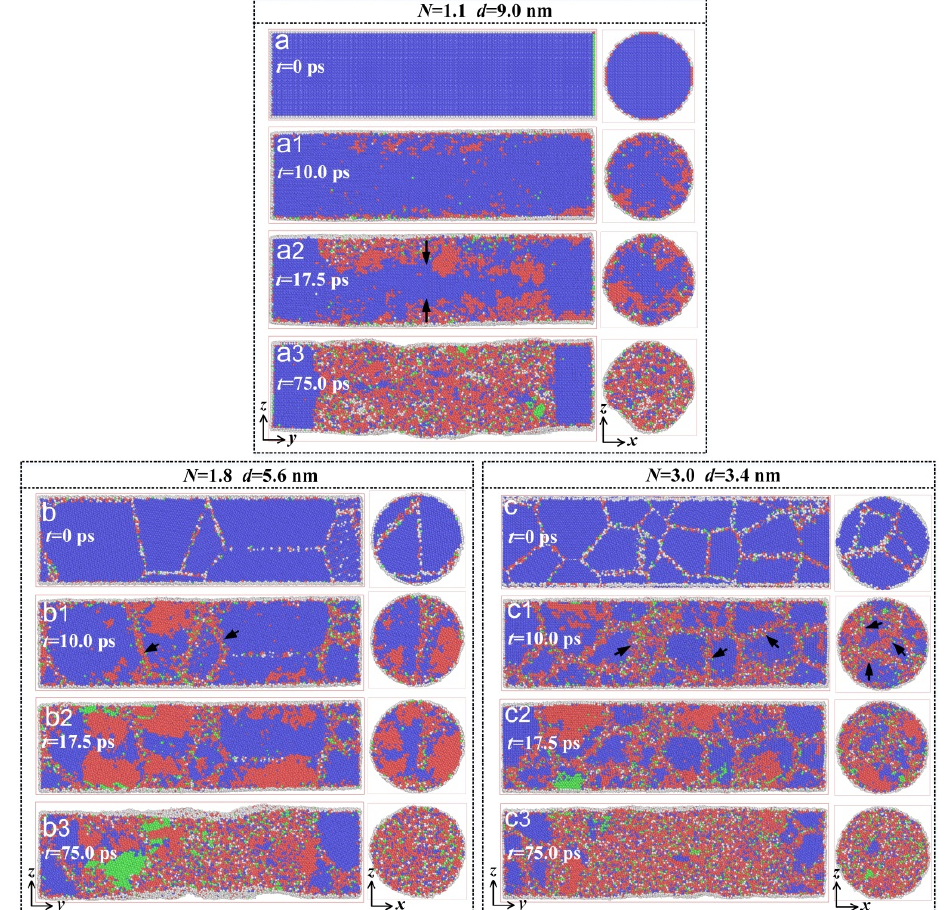
Figure 5. The microstructural evolution of different models at various times during the torsion sim- ulation. (a) Single crystal model with an average grain size of 9.0 nm, t = 0 ps; ( a1 ) t = 10.0 ps; ( a2 ) t = 17.5 ps; ( a3 ) t = 75.0 ps. ( b ) Polycrystalline model with an average grain size of 5.6 nm, t = 0 ps; ( b1 ) t = 10.0 ps; ( b2 ) t = 17.5 ps; ( b3 ) t = 75.0 ps. ( c ) Polycrystalline model with an average grain size of 3.4 nm, t = 0 ps; ( c1 ) t = 10.0 ps; ( c2 ) t = 17.5 ps; ( c3 ) t = 75.0 ps. The blue atoms correspond to austenites, the red atoms to martensites, the green atoms to highly stressed austenites, and the white atoms to other structures that cannot be recognized by OVITO.